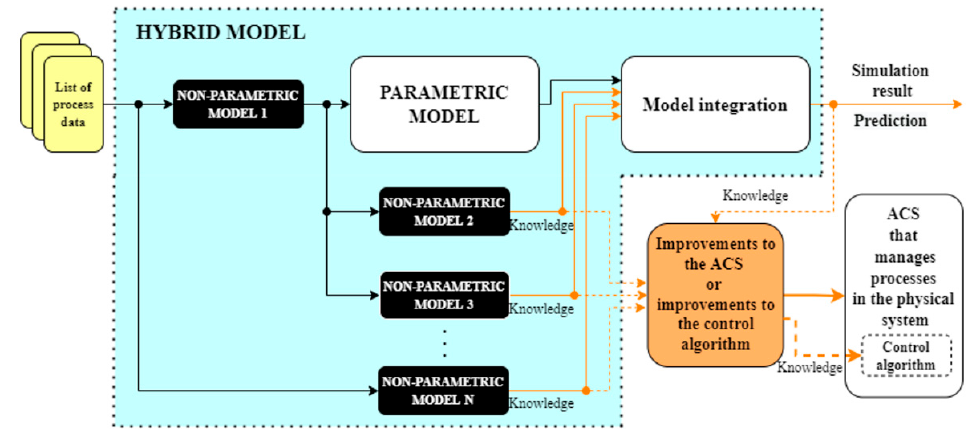
Figure 1. Serial-parallel hybrid model structure.